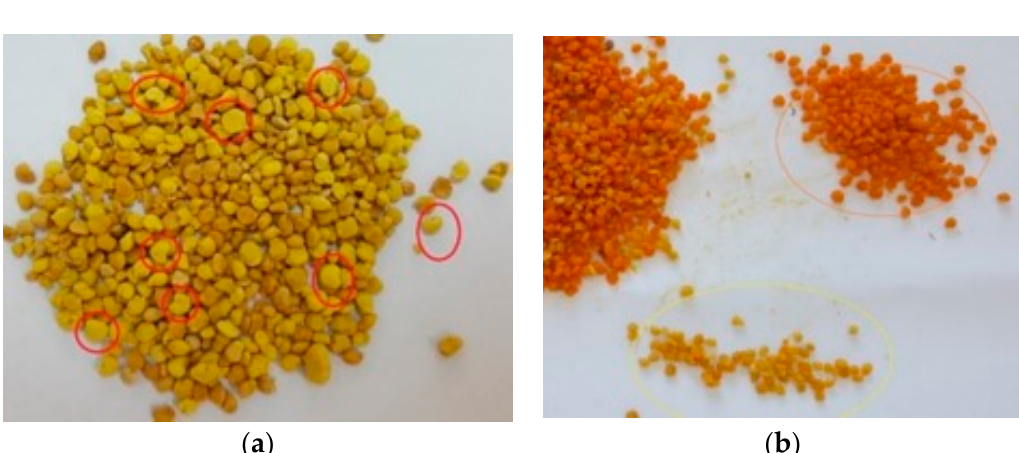
Figure 2. Example of honeybee multi-floral pollen samples collected by honeybees in the two studied periods. The rape, sunflower and corn pollens pellets were selected in the laboratory when preparing the samples to be analyzed. ( a ) A pollen sample collected during the oilseed rape ( Brassica napus ) blooming. One can notice an amount of approximately 50% oilseed rape pollen, (indicated by red circles). ( b ) A pollen sample collected during the sunflower ( Helianthus annuus ) and corn ( Zea mays ) blooming. One can notice an amount of approximately 60% sunflower pollen (orange) versus 40% corn pollen (yellow). Photos © Institute for Beekeeping Research and Development, Bucharest.